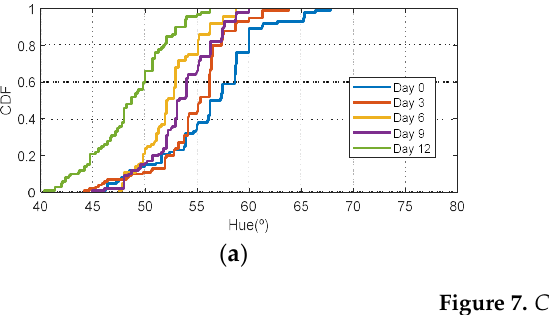
Figure 6. Histogram for the golden apple for different days: Histogram of the hue ( a ), saturation ( b ) and value ( c ) parameters in the fridge. Histogram of the hue ( d ), saturation ( e ) and value ( f ) parameters at room temperature.